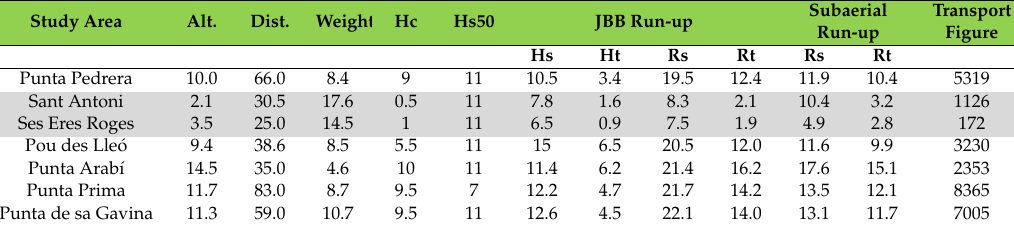
Subaerial Run-up Hs Ht Rt